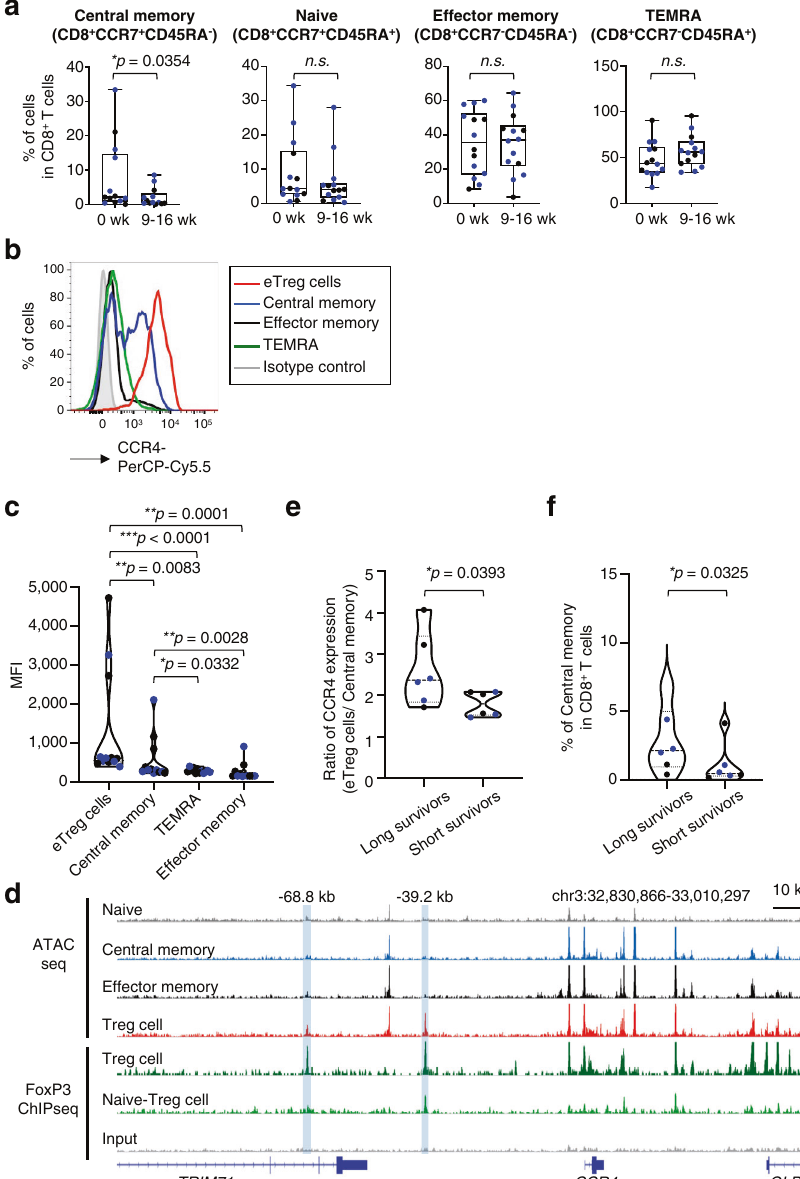
Fig. 4 Central memory CD8 + T cells with CCR4 expression are decreased after mogamulizumab treatment. a Summaries for the frequencies of each CD8 + T cell fraction (central memory CD8 + T cells, * p = 0.0354) as depicted in Fig. 2f at pre- and post-mogamulizumab treatment are shown. PBMC samples ( n = 14), as in Fig. 2, were subjected to fl ow cytometry. b , c Representative fl ow cytometry staining for CCR4 in each CD8 + T cell fraction in comparison with that in eTreg cells ( b ) and summary for the CCR4 expression levels (MFI) in central memory CD8 + T cells (to eTreg cells, ** p = 0.0083), effector-memory CD8 + T cells (to eTreg cells, ** p = 0.0001 and to central memory CD8 + T cells, ** p = 0.0028), TEMRA CD8 + T cells (to eTreg cells, *** p < 0.0001 and to central memory CD8 + T cells, * p = 0.0332) and eTreg cells ( c ) are shown ( n = 12). Red line, eTreg cells; blue line, central memory CD8 + T cells; black line, effector-memory CD8 + T cells; green line, TEMRA CD8 + T cells; fi lled gray area, control staining. d Sequencing tracks of ATAC- seq regarding four T cell subsets (naive CD8 + T cells, central memory CD8 + T cells, effector-memory CD8 + T cells and Treg cells) and FoxP3 ChIP-seq about Treg cells around the CCR4 gene locus. The normalized ATAC-seq and ChIP-seq read coverage were used to visualize the tracks. ATAC seq about each T cell subset (gray: naive CD8 + T cells, blue: central memory CD8 + T cells, black: effector-memory CD8 + T cells, red: Treg cells) and FoxP3 ChIP-seq about Treg cells (green: Treg cells, light green: naive Treg cells, grey: IP control) are shown. e Ratio of CCR4 expression levels (mean fl uorescence intensity: MFI) in central memory CD8 + T cells to eTreg cells (* p = 0.0393) in long survivors ( ≥ 1 year, n = 6) and short survivors (< 1 year, n = 6) is shown. f The frequency of central memory CD8 + T cells in CD8 + T cells after mogamulizumab treatment (* p = 0.0325) in long survivors and short survivors is shown ( n = 6). In ( a , c , e and f ), black dots, patients who received 1.0 mg/kg mogamulizumab; blue dots, patients who received 0.1 mg/kg mogamulizumab. In ( a and c ), two-sided, ( e and f ), one-sided Mann – Whitney test was used. In a , the center line indicates the median, and the box limits indicate the 1st and 3rd quartiles. The whiskers go down to the smallest value and up to the largest. week: wk, naive CD8 + T cells: Naive, central memory CD8 + T cells: Central memory, effector-memory CD8 + T cells: Effector memory, TEMRA CD8 + T cells: TEMRA. * p < 0.05, ** p < 0.005, *** p < 0.0001. Source data are provided as a Source Data fi